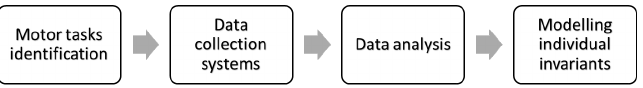
Figure 3. GPSJack/GPSEnv system design workflow.